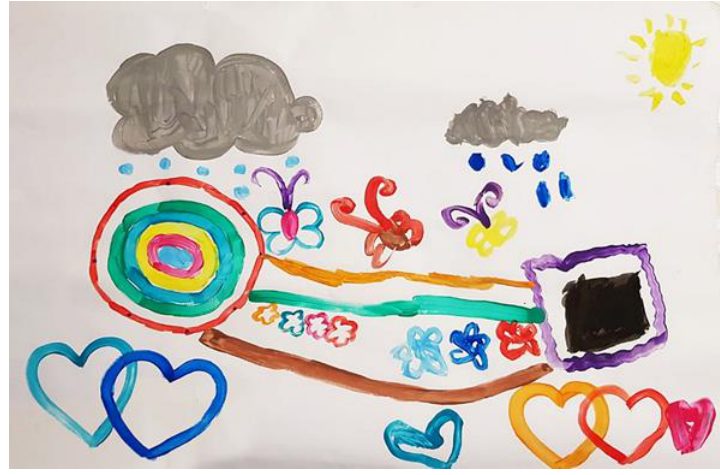
Figure 4. Meital and her